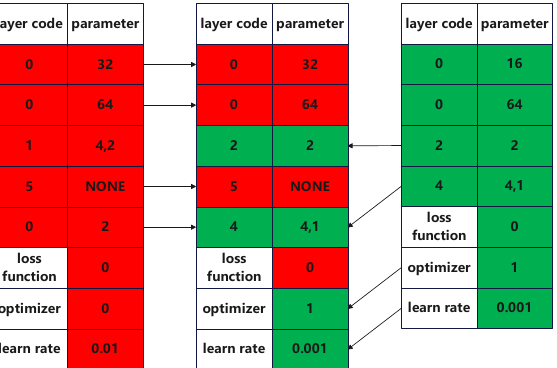
Figure 3. Solution p z are produced from the crossover of parents p x and p y